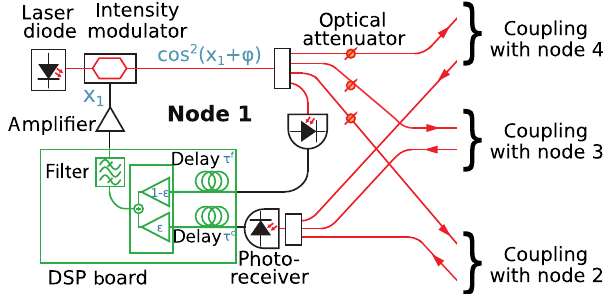
FIG. 2. Illustration of optoelectronic oscillator and coupling scheme. Red lines indicate signal paths in optical fibers. Black lines are used to indicate electronic signals, and green indicates the DSP